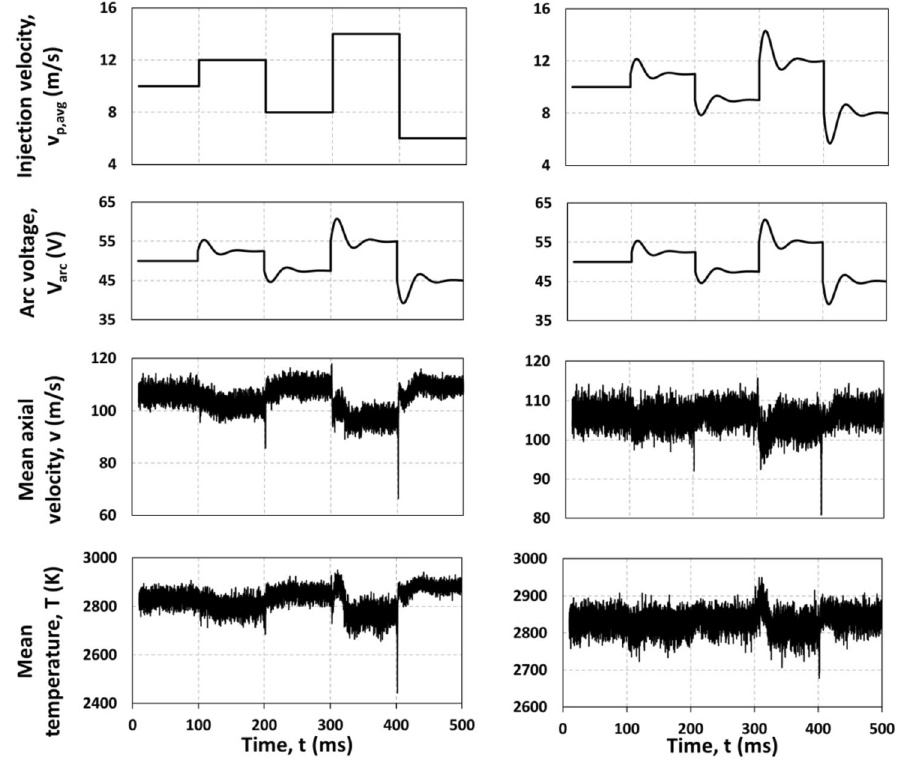
Fig. 3 Effect of combined vari- ations in the average injection velocity of ZrO particles and 2 the arc voltage on the MPSs just before they arrive at the